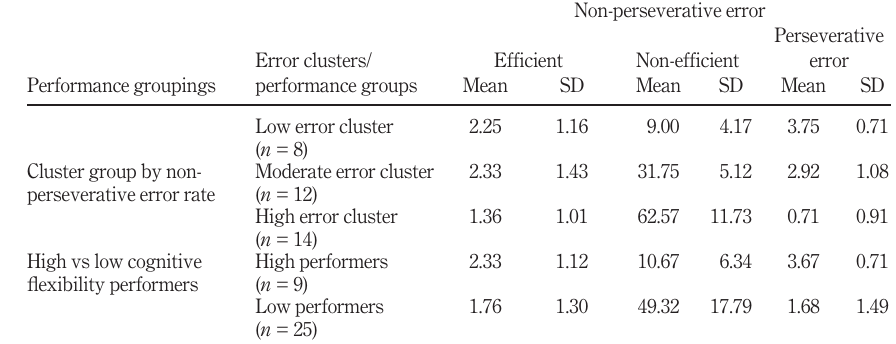
Table II. Descriptive statistics of error type by cluster group and performance